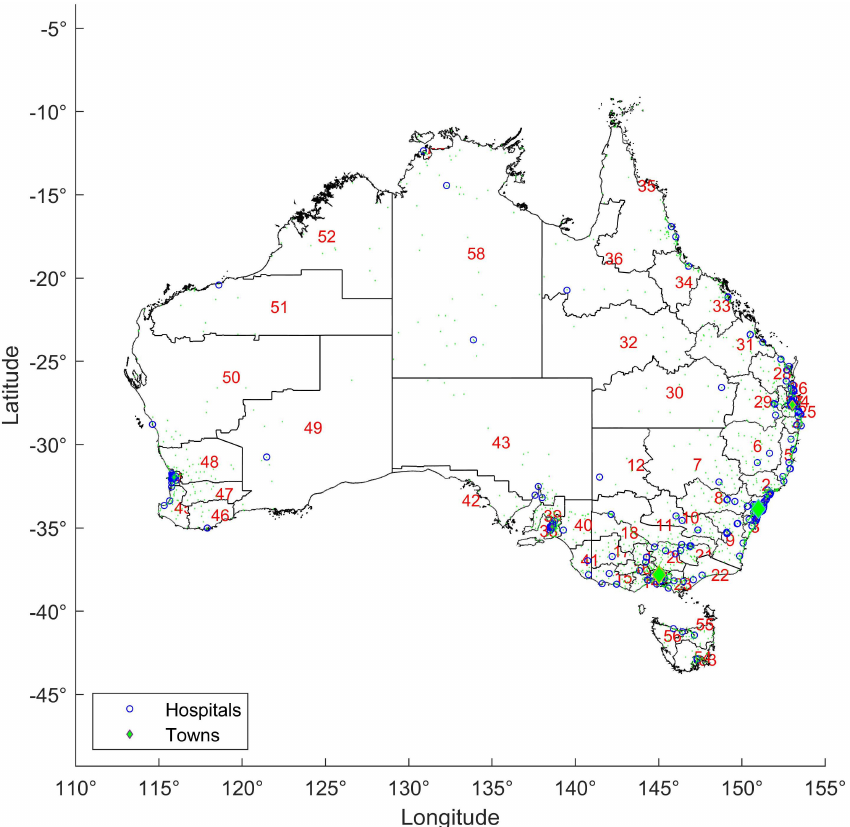
Figure 1. Towns and